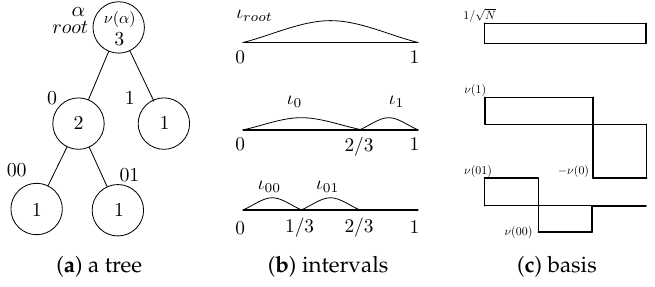
Figure 1. Binary tree and corresponding intervals for the basis. ( a ) Binary tree having N = 3 leaves, where each node is labeled with 0 and 1 outside the circle except for root; ( b ) intervals corresponding to the nodes; ( c ) the basis built from the